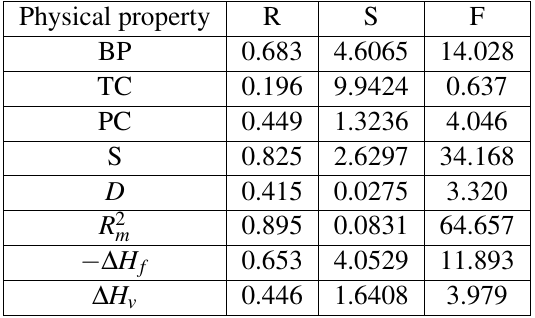
Table 6 Statistical parameters for the linear QSPR model (4).